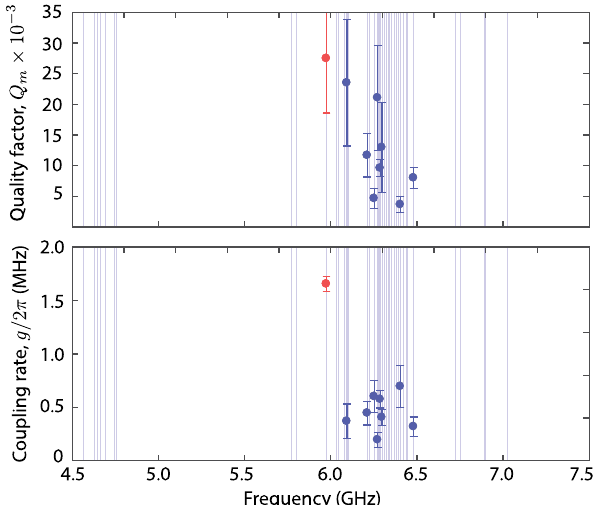
FIG. 6. Mechanical spectrum. Quality factors Q (top panel) and m coupling rates g (bottom panel) of various modes are plotted as a function of frequency. The positions of all modes observed in this device are indicated by vertical blue lines, clearly showing that the resonances tend to tightly cluster within certain regions. All of these resonances were verified to be linear in the same way as the mode presented in the main text, ruling out TLS resonances. In = 2 π ¼ 5 . 975 GHz presented in the both plots, the resonance at ω m main text is indicated by the red point. The quality factors and coupling rates are obtained through reflection spectra collected at − ω various detunings Δ ¼ ω around each mechanical mode r m and fitted to Eq. (2); error bars indicate the standard deviation of the parameter estimates for these fits.